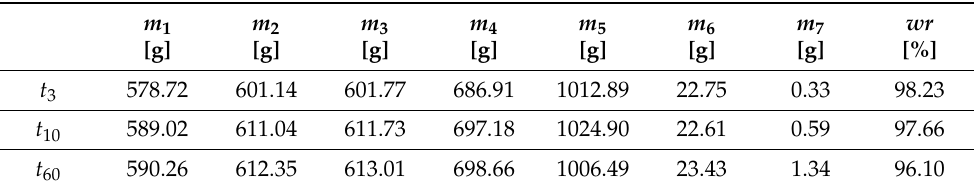
Table 5. Results of the water retention test performed on one mortar specimen reinforced with RM1 dispersed fibers.